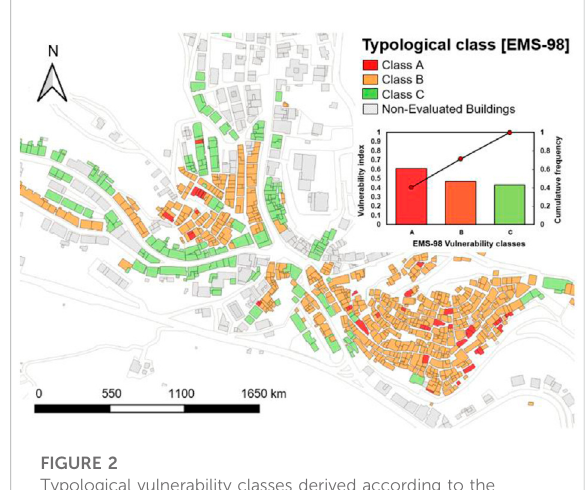
FIGURE 1 Large-scale vulnerability analysis of a historical sector of the municipality of Latronico.